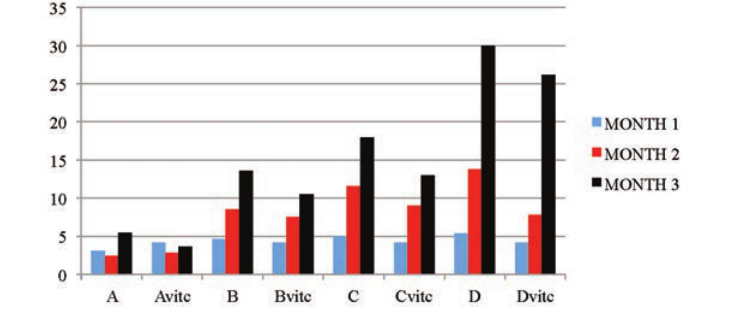
Figure 3. The mean serum urea (mmol/L) values of the different subgroups during the three months study period.